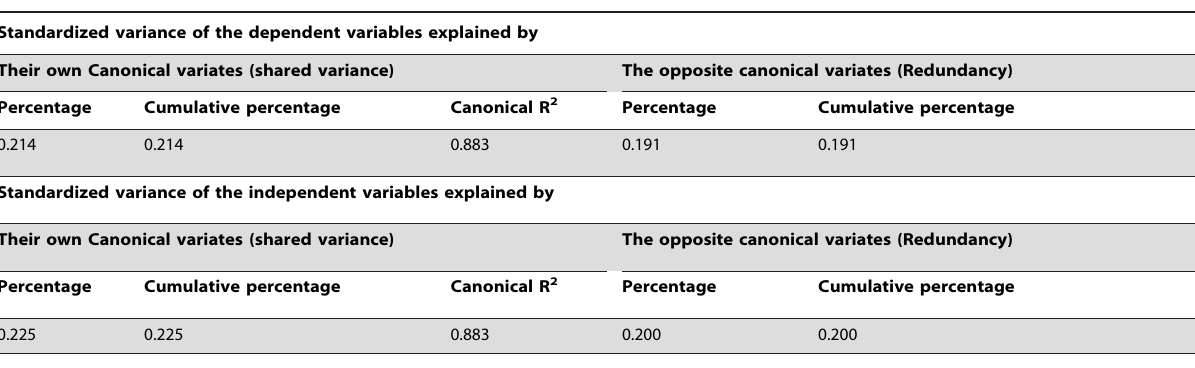
Table 5. Redundancy analysis of dependent and independent variates for the first canonical function.